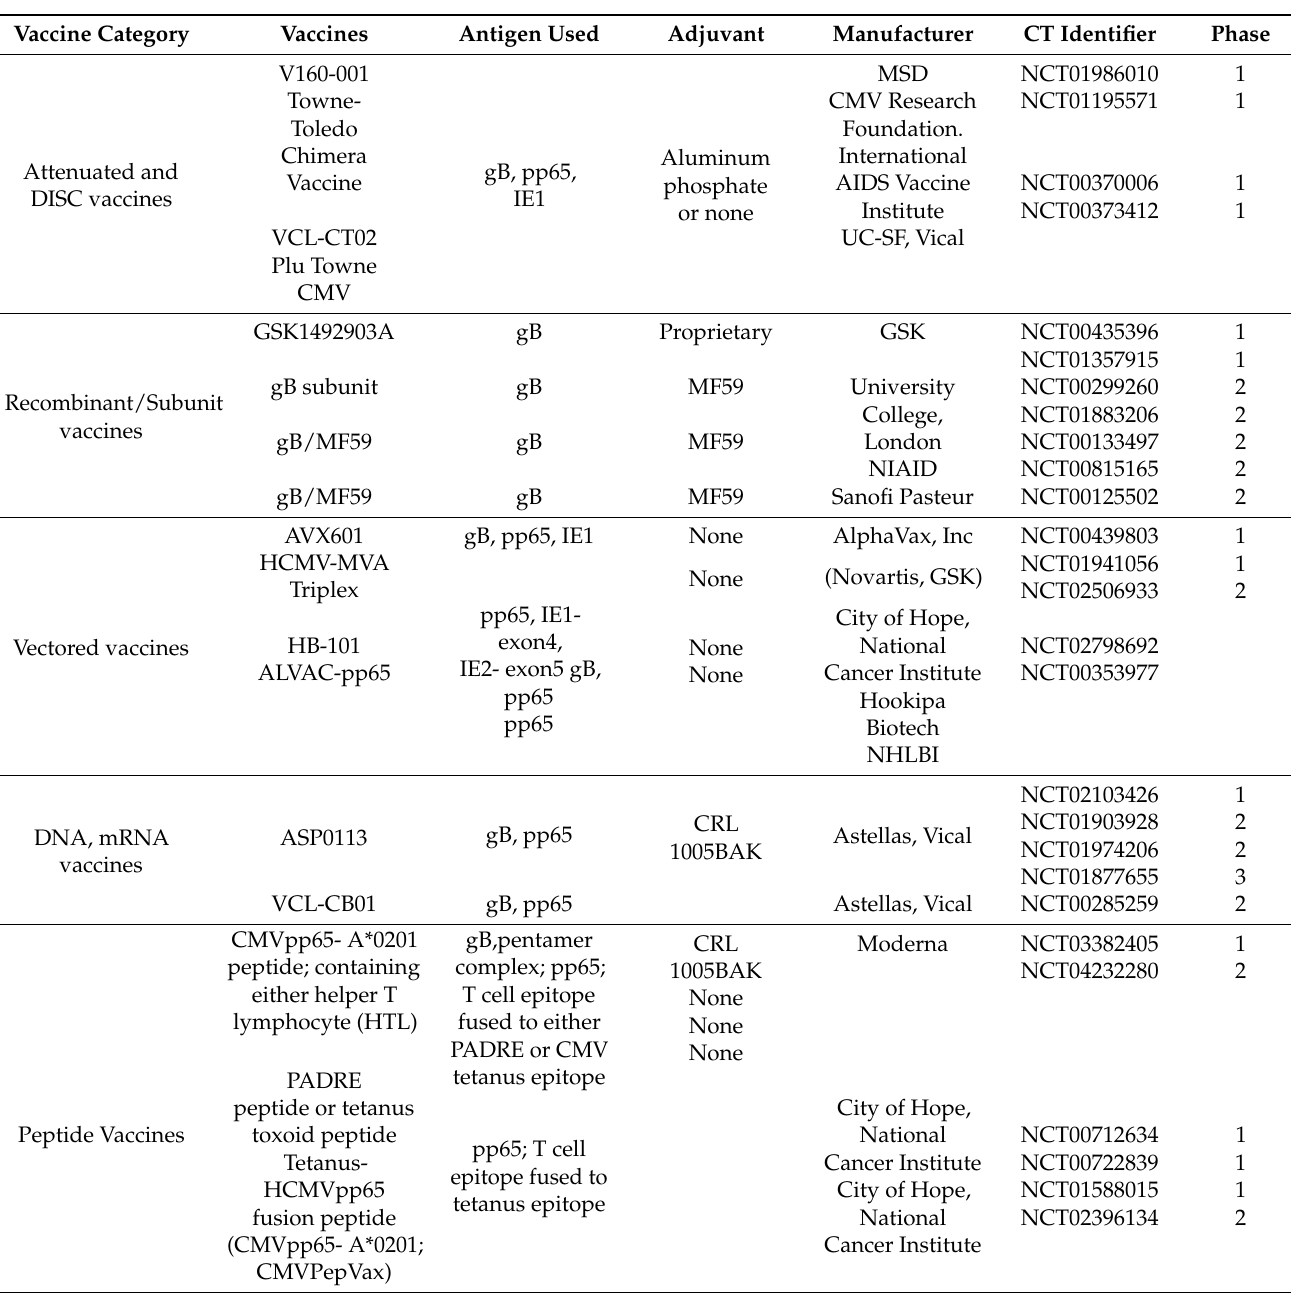
Table 1. Main CMV vaccines under clinical